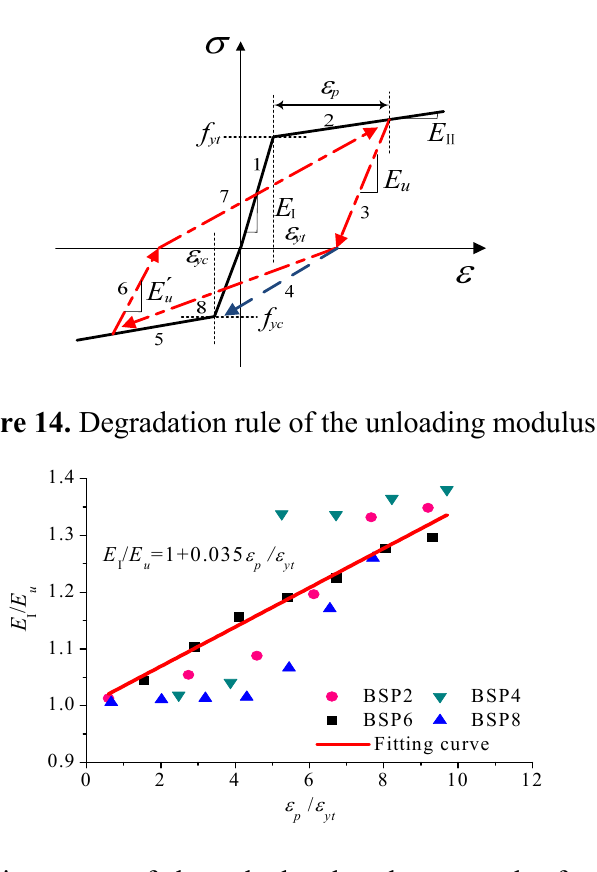
Figure 13. Stress–strain restoring force model of BSP.